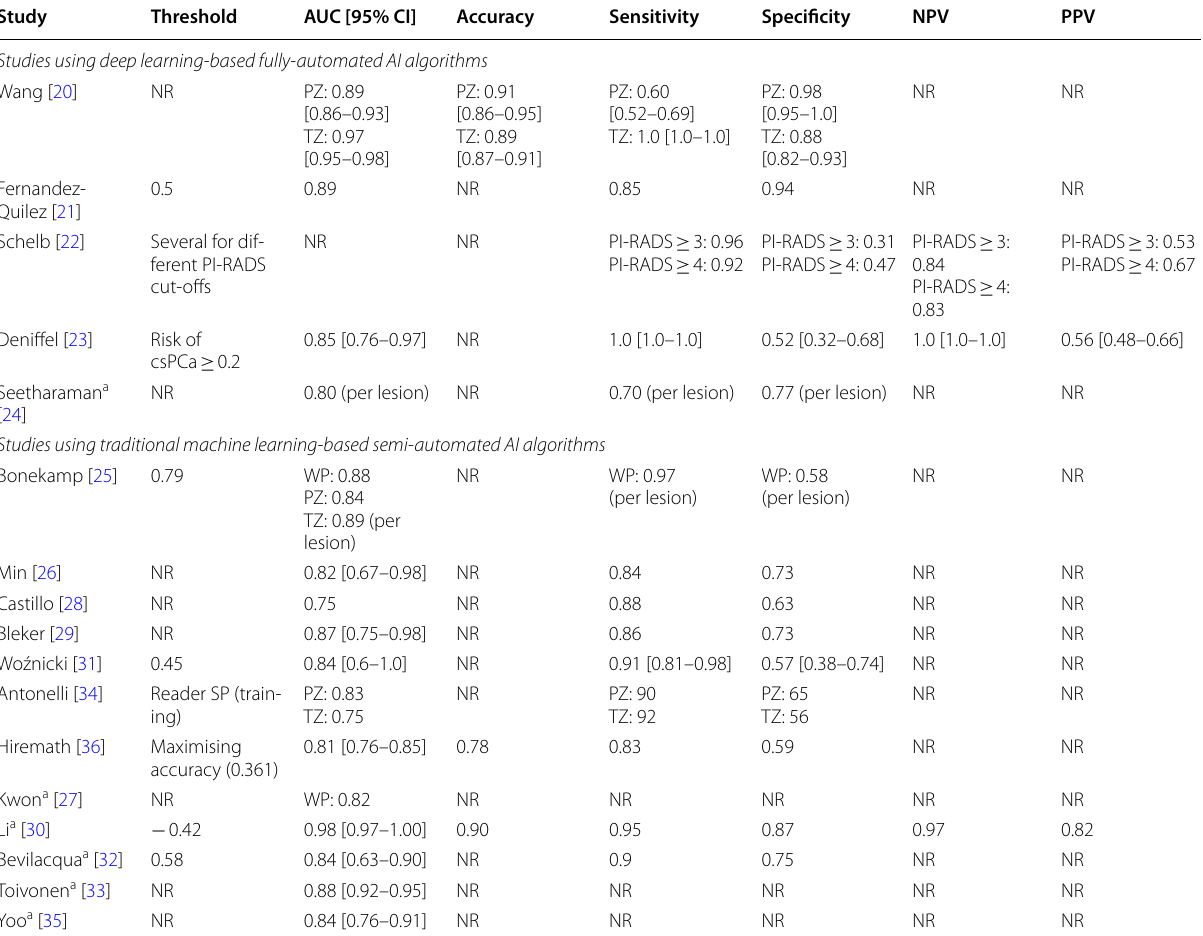
Table 5 Diagnostic performance of fully-automated and semi-automated AI methods for differentiating between csPCa and iPCa or benign